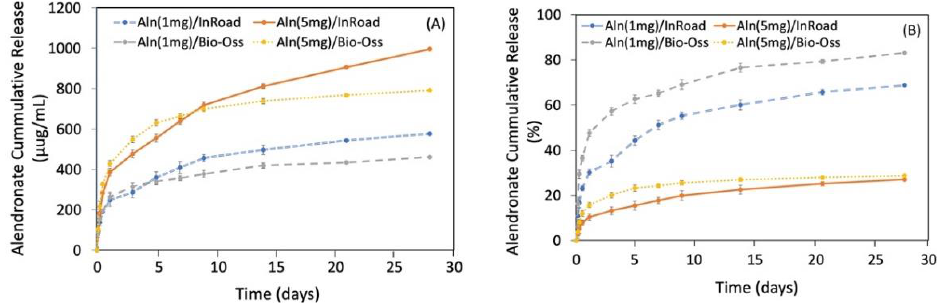
Figure 5. ( A ) Cumulative in vitro release profile of Aln from Aln (1 mg)/InRoad, Aln (1 mg)/Bio- Oss, Aln (5 mg)/InRoad, and Aln (5 mg)/Bio-Oss. Released Aln from both InRoad and Bio-Oss were similar within each concentration. ( B ) Percentage cumulative in vitro release profile of Aln showed that Aln concentration affected Aln releasing pattern. On the first day, 30.21 ± 1.09% and 47.62 ± 1.18% of Aln was released from Aln (1 mg)/InRoad and Aln (1 mg)/Bio-Oss, respectively. While 10.41 ± 0.99% and 15.71 ± 1.26% of Aln was released from Aln (5 mg)/InRoad and Aln (5 mg)/Bio- Oss, respectively. On the 28th day, 68.73 ± 1.15% and 83.09 ± 0.89% of Aln was released from Aln (1 mg)/InRoad and Aln (1 mg)/Bio-Oss, whereas 27.02 ± 0.67% and 28.70 ± 0.63% of Aln was released from Aln (5 mg)/InRoad and Aln (5 mg)/Bio-Oss.